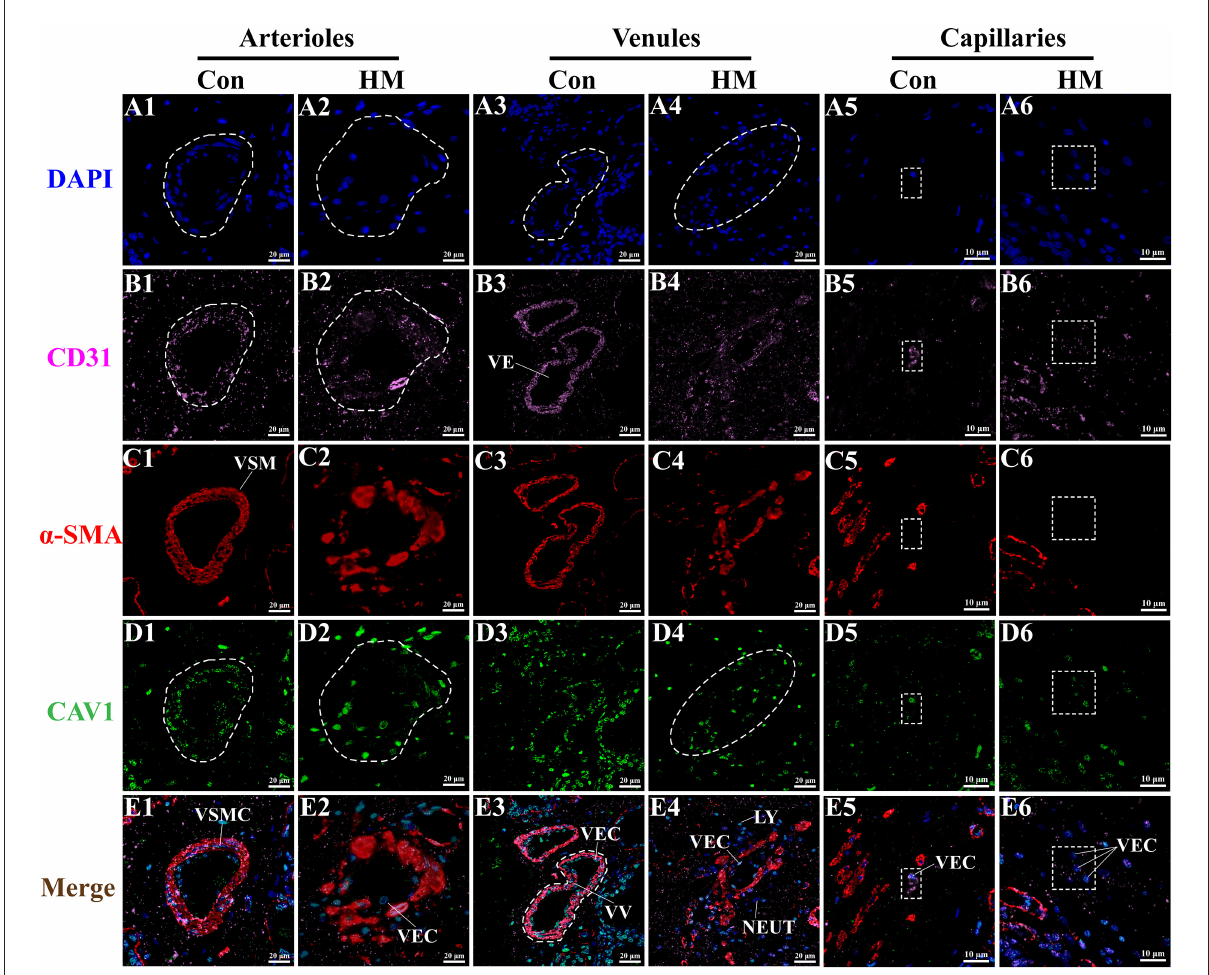
FIGURE8 Co-localization analysis, via immunofluorescent staining, of CAV1 protein in the mammary gland tissues of healthy and hemorrhagic mastitis Holstein cows. (A1–A6) the nuclei of different types of cells labeled with DAPI. (B1–B6) CD31 protein in the VECs of blood vessels. (C1–C6) α -SMA protein in VSMCs of blood vessels. (D1–D6) localization analysis of CAV1 protein in the mammary gland tissues. (E1–E6) , Co-localization analysis of CAV1, CD31, and α -SMA proteins in blood vessels of the mammary gland tissues in healthy and experimental Holstein cows. VEC, vascular endothelial cell; VSMC, vascular smooth muscle cell; NEUT, neutrophil; VV, venous valve; Con or C, Control group; HM, Hemorrhagic mastitis group. Scale bar of 50 and 20 µ m represents 400 × and 800 × magnification,